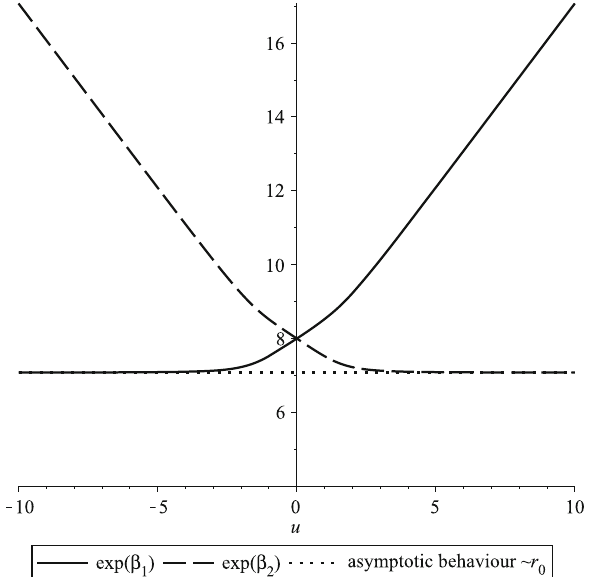
Fig. 6 Radiioftwo-dimensionalsubspacesvstheSchwarzschildradial coordinate u for parameter values a = − 2 , b = 1 , c = − 0 . 02, ξ 3 = 1 . 85